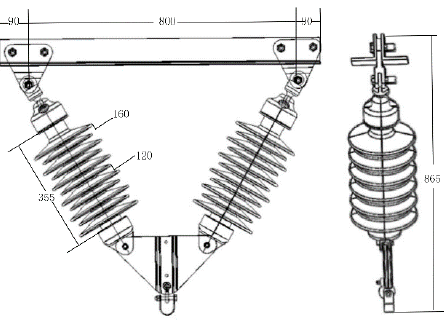
Figure 3. Structural diagram of V-type double suspension rod insulators.